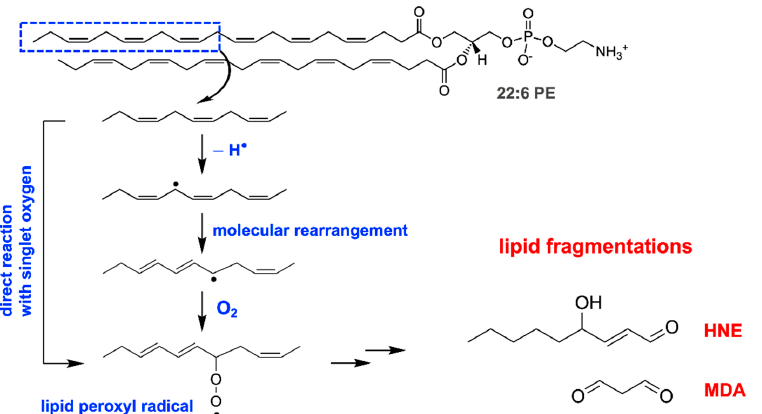
Figure 2. Photosensitization can initiate lipid peroxidation. Reaction with singlet oxygen leading to lipid peroxide formation in the hydrophobic interior of lipid membranes. 1,2-Didocosahexaenoyl- sn -glycero-3-phosphoethanolamine (22:6 PE) that contains polyunsaturated fatty acids is shown. Hydroxyl radicals also initiate lipid peroxidation via hydrogen atom abstraction from a methylene (-CH 2 -) group. Once peroxyl radicals are generated through multiple steps (stacked arrows), the peroxyl radicals cause the formation of aldehyde-bearing end products of lipid peroxidation